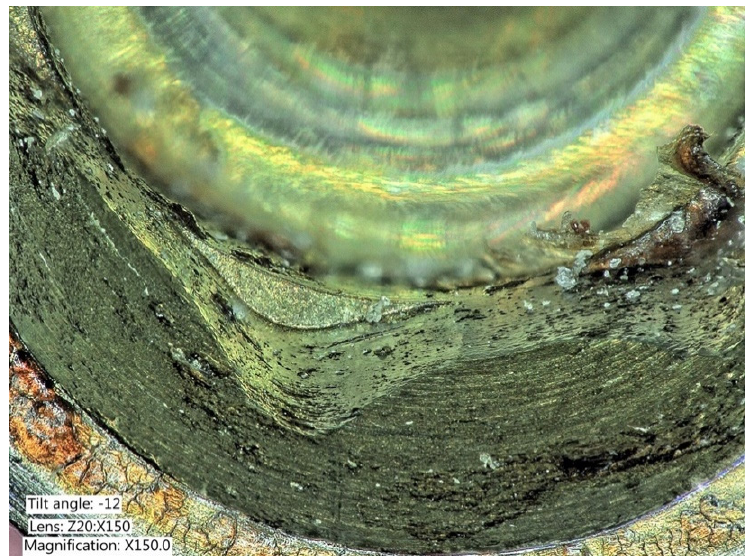
Figure 10. Closer view of an explanted implant with a hexagonal connection. Corrosion, delamina- tion, and abrasions of the connection surface can be appreciated.